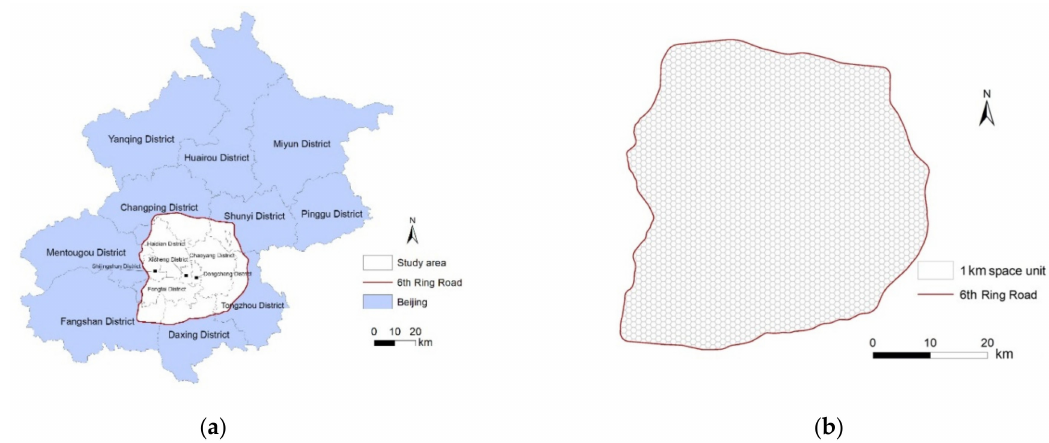
Figure 1. ( a ) Study area within the 6th Ring Road in Beijing, China; ( b ) expanded study area, showing its 2745 hexagonal (1 km × 1 km) spatial